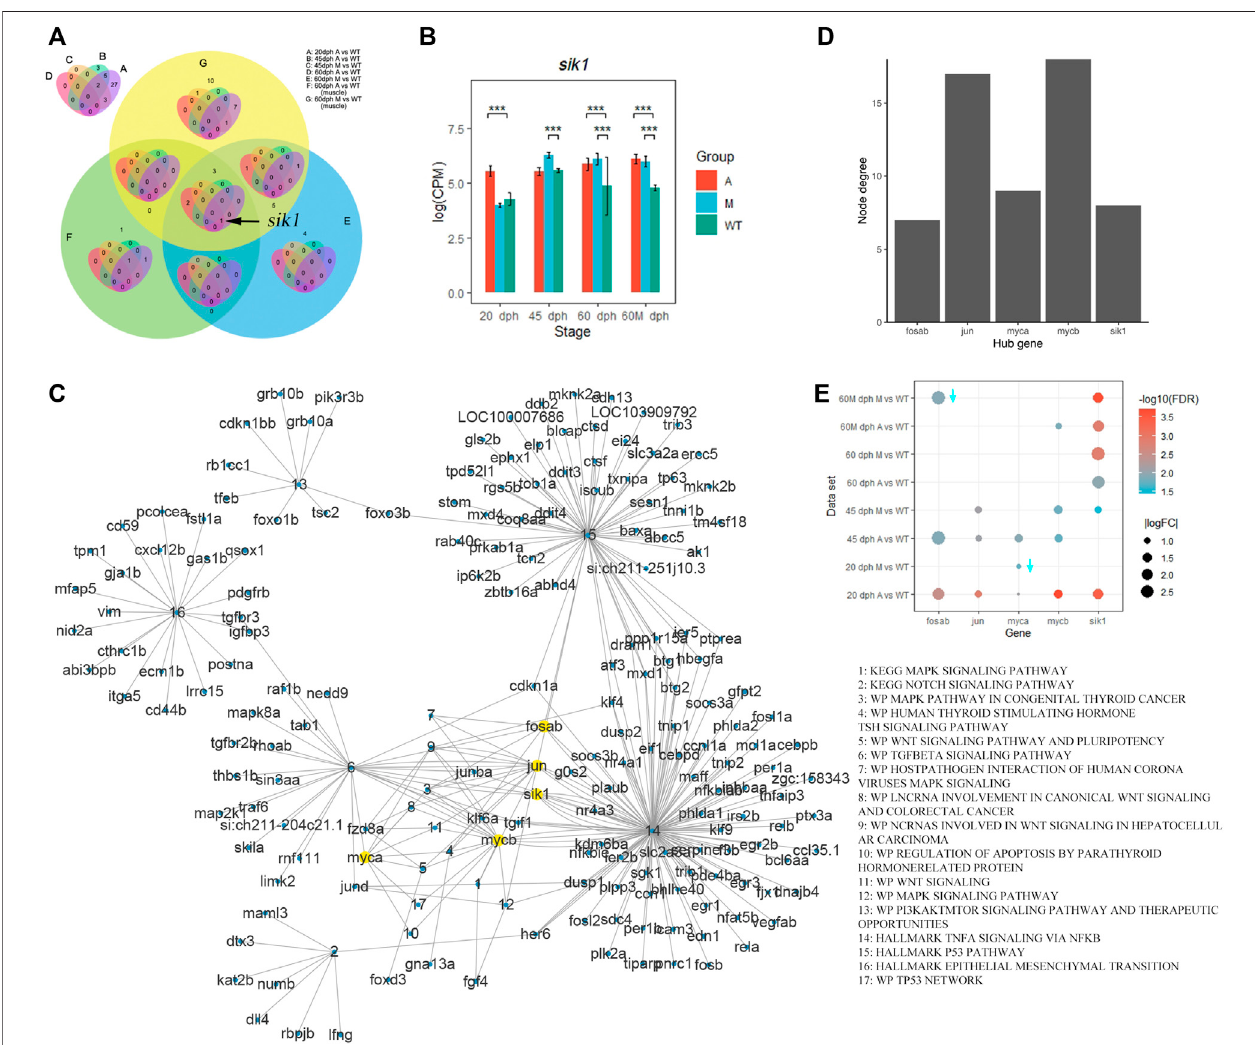
FIGURE7| Sik1 wasakeyregulatorygeneofpathwaysrelated toIBdevelopment. (A) VennplotofgenesenrichedintheTNFAsignaling via theNF-KBpathwayin different comparative groups. (B) Expression level of sik1 in different groups. *** p < 0.001 (C) Complex gene – pathway interaction network of pathways related to bone development enriched by upregulated genes in mutants compared with wild-type. (D) Node degree of hub genes. (E) Differential expression of hub genes. Downward arrow means that logFC is less than zero.